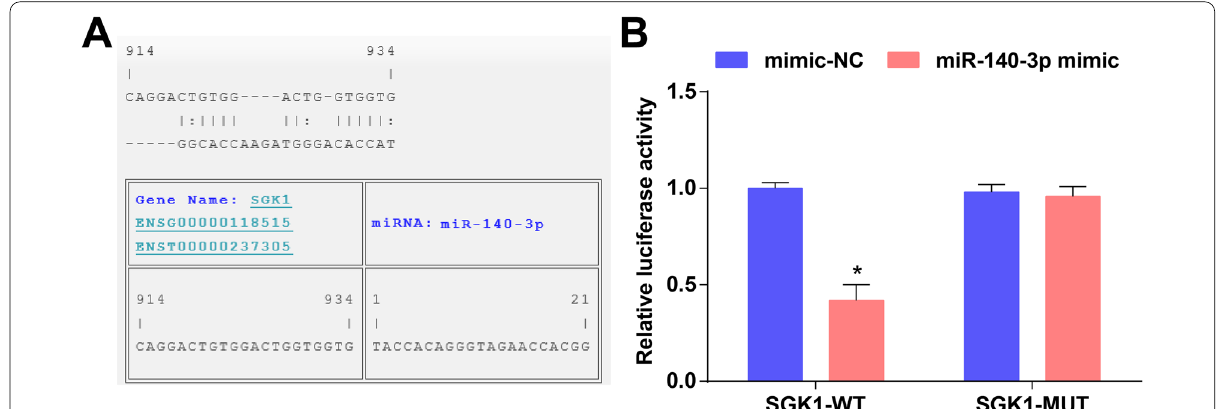
Fig. 5 MiR-140-3p targets SGK1. A Binding sites of miR-140-3p and SGK1 were predicted by a bioinformatic website; B Target relationship between miR-140-3p and SGK1 was confirmed by dual luciferase report gene assay; * P < 0.05 vs the mimic-NC group; the data were expressed as mean standard deviation and the t-test was performed for comparisons between two ±